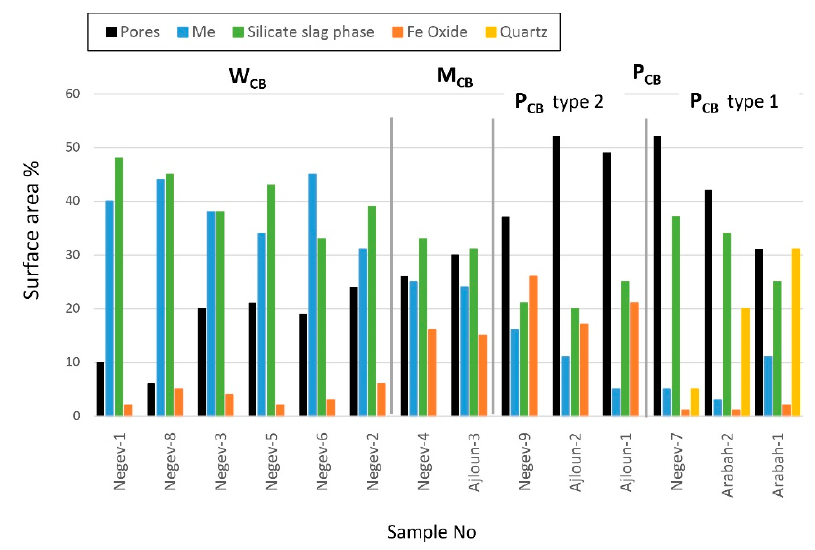
Figure 7. The correlation (%) between porosity, reduced metallic area, newly formed silicate slag area, iron oxide area, and quartz area, according to bloom consolidation degree (W CB , M CB , P CB -type 1, P CB -type 2).